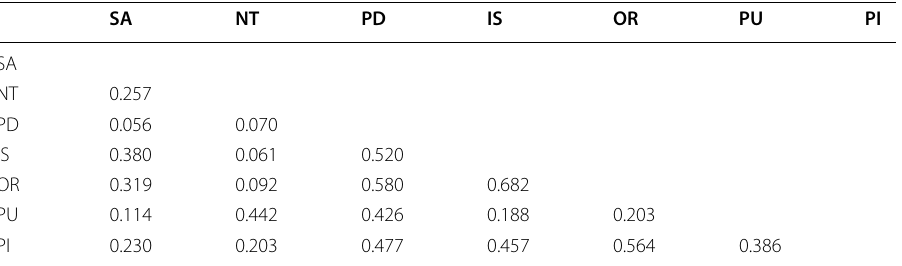
Table 2 Heterotrait–monotrait (HTMT)